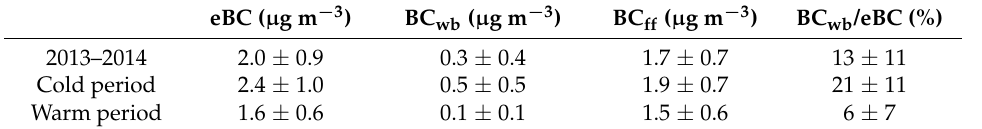
Table 2. 24-h concentrations (in µ g m − 3 ) of equivalent black carbon (eBC), and black carbon related to wood burning (BC wb ) and fossil fuel combustion (BC ff ) (mean ± standard deviation). The relative contribution (%) of wood burning to eBC (BC wb /eBC) is also provided.